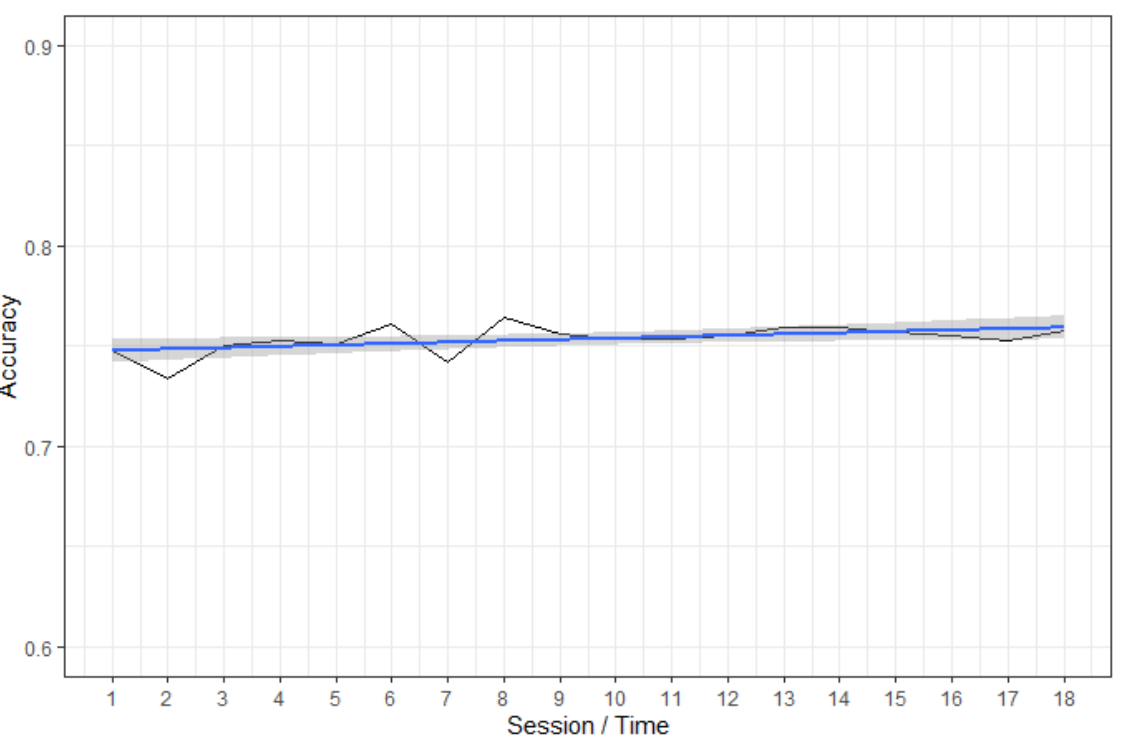
Figure 9. Accuracy score for collaborating users over time averaged across news type categories.